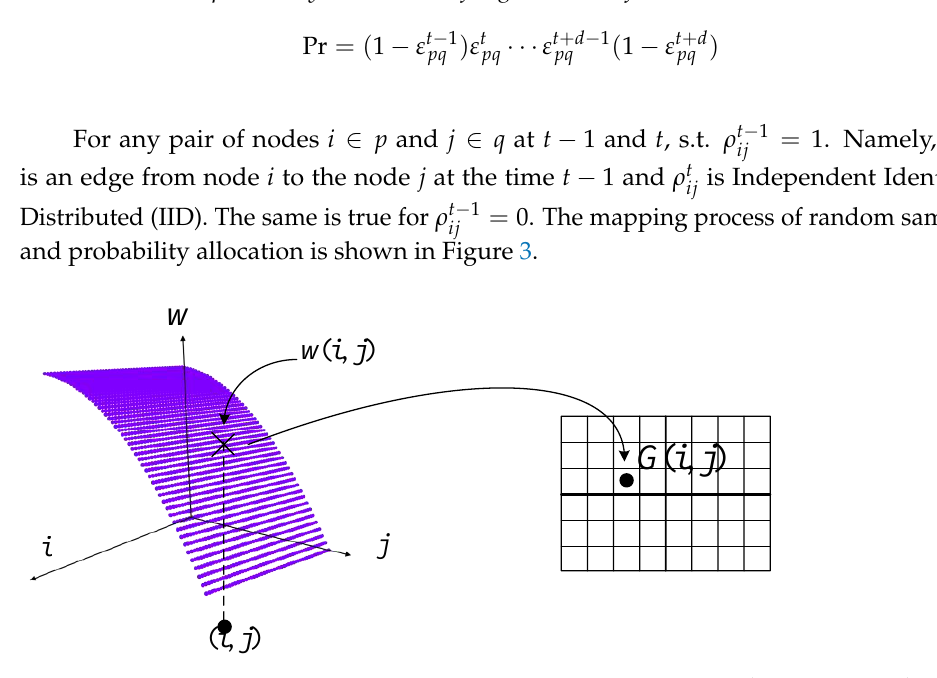
= 1, ρ t ∼ Bernoulli ( ε t ij ij